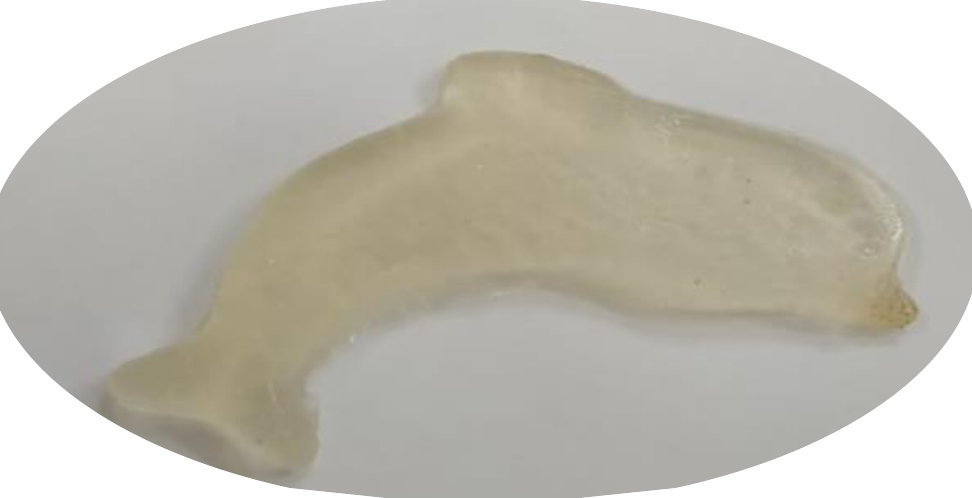
Figure 1. Dolphin gel formed by the blending of Carr/starch blend with superior water-absorbing capability.